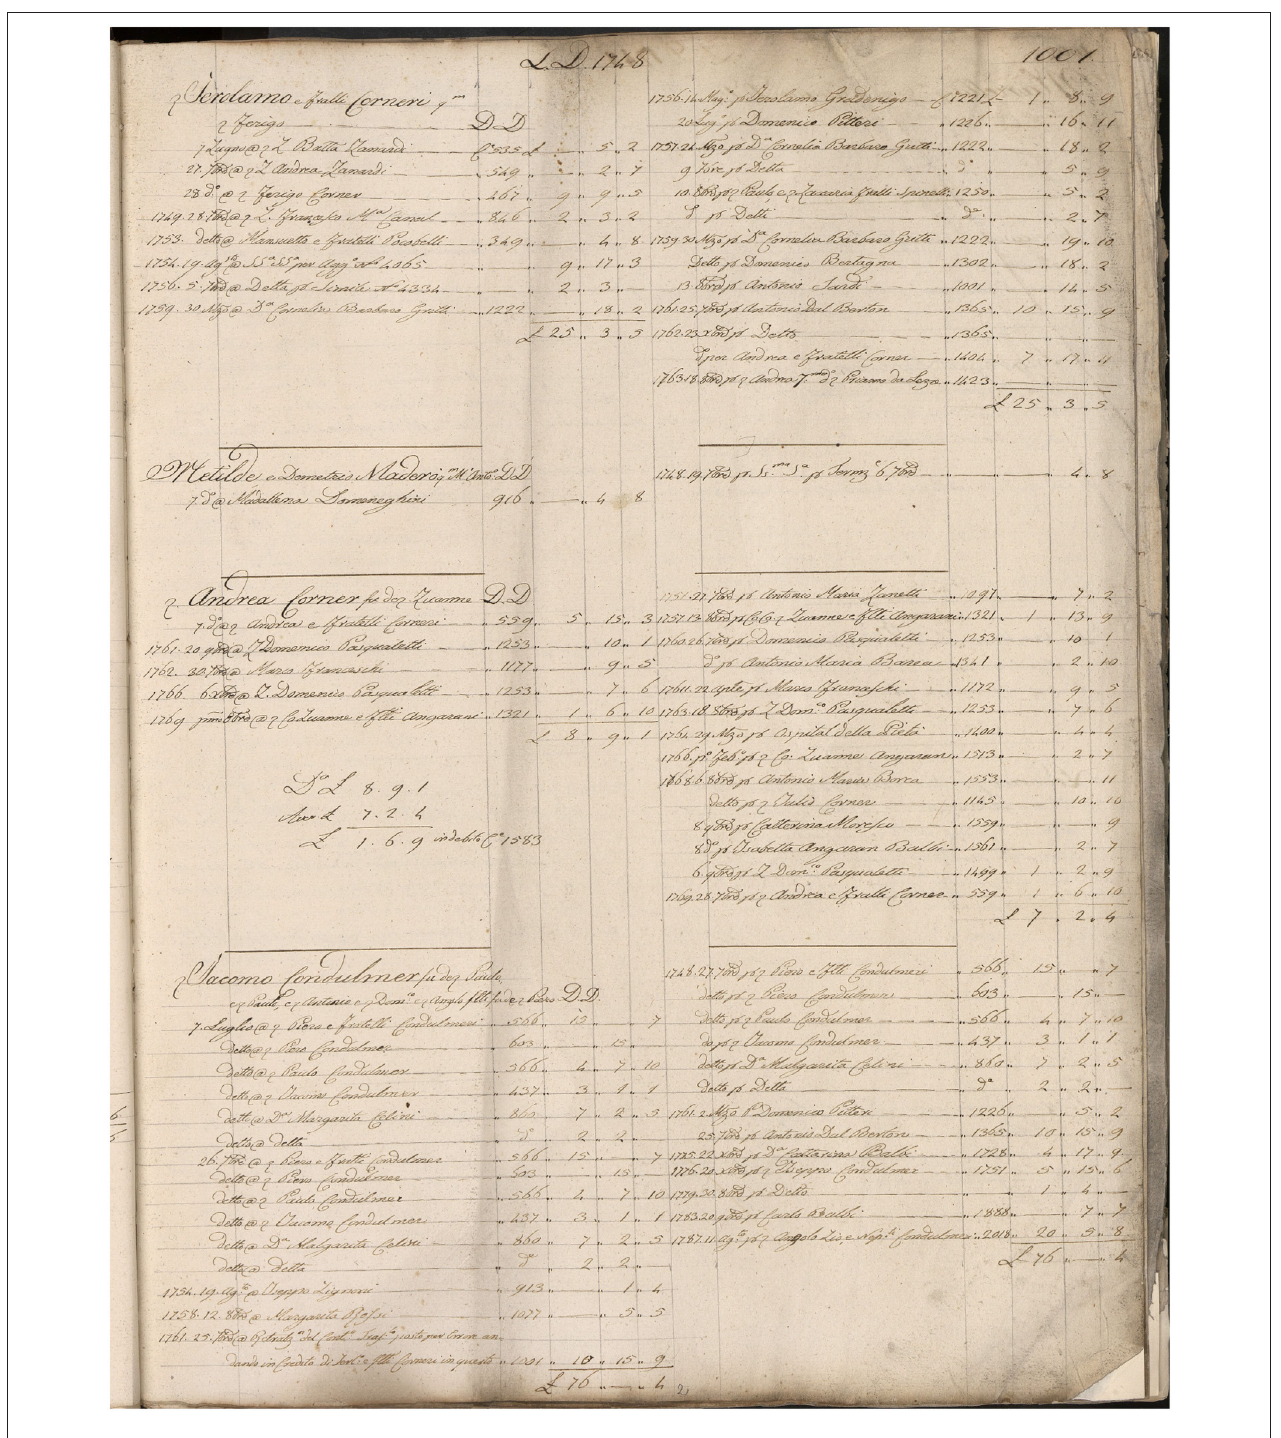
FIGURE 4 | A set of accounts in a register of the Quaderni . Note that the sheet is marked as 1001 (top-right corner). The third entry refers to “ser Andrea Corner fu domino Zuanne.” There are five accounts per page. Andrea’s is filled with transactions. The left column is for newly acquired possessions (for which he needs to give, or dare , a certain amount of tax), the right column is for lost possessions (for which he needs to be relieved from a certain amount of tax, or avere ). From: State Archive of Venice, X Savi alle decime in Rialto , Catastici delle parrocchie , r. 1529, c. 2r.